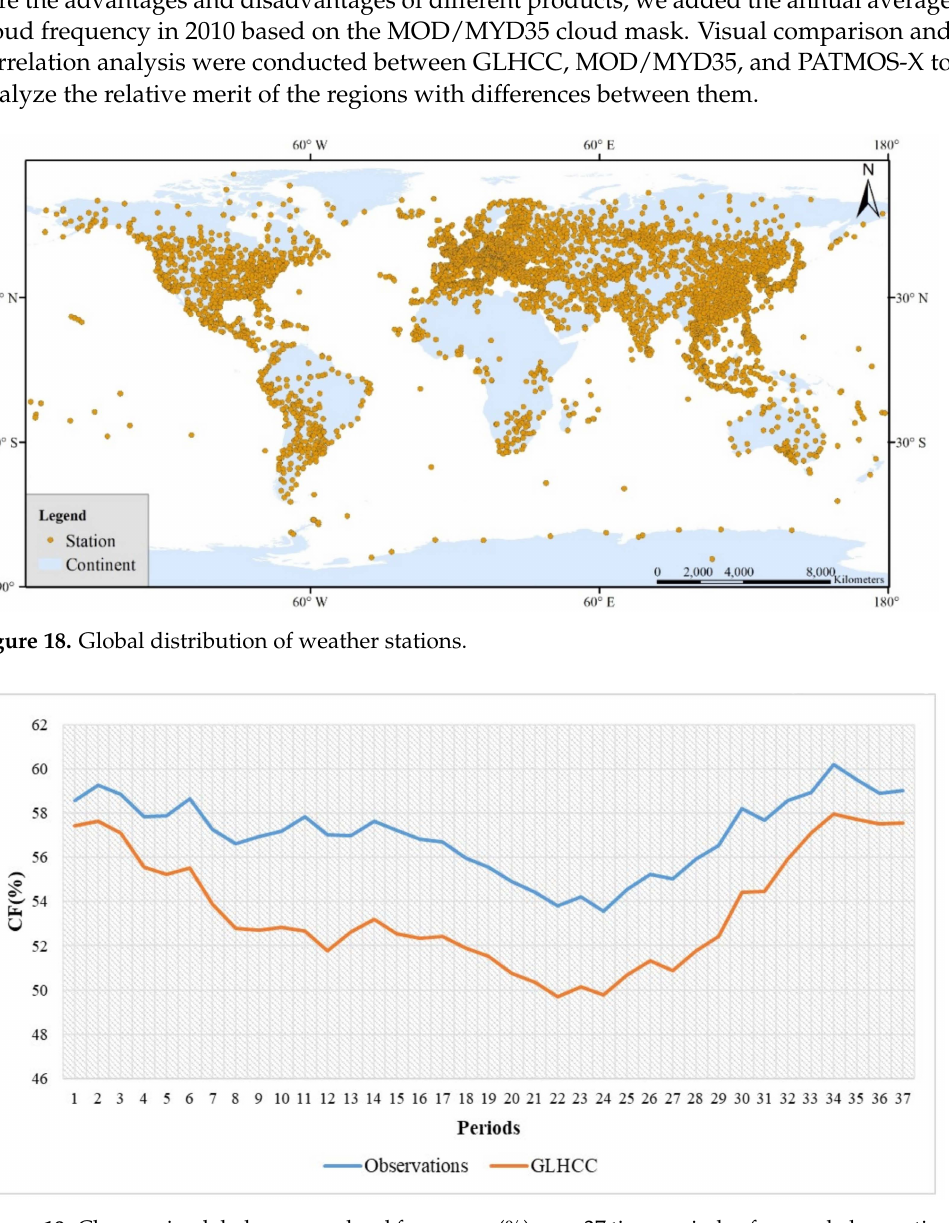
Figure 19. Changes in global average cloud frequency (%) over 37 time periods of ground observation data and GLHCC